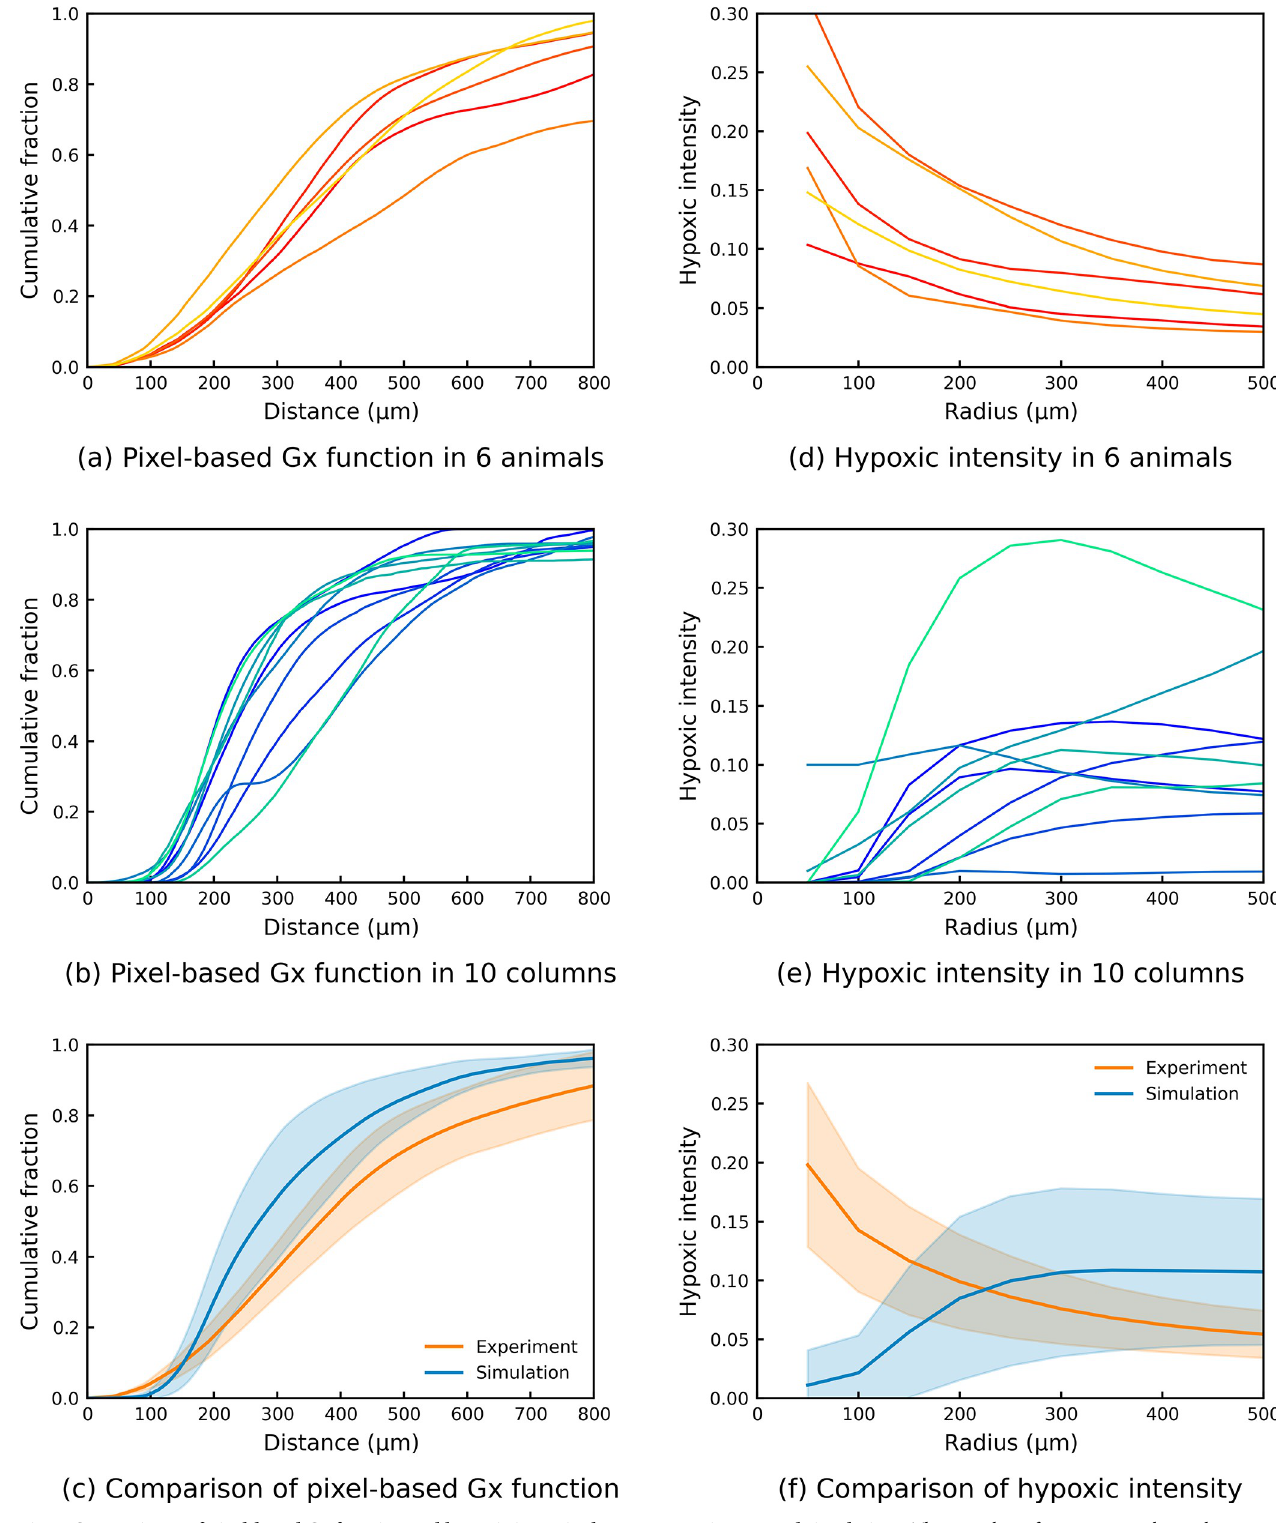
Fig 9. Comparisons of pixel-based Gx function and hypoxic intensity between experiments and simulations. The error bar of experiments shows the standard deviation between 6 animals. The error bar of simulation shows the standard deviation between 10 cortical columns.